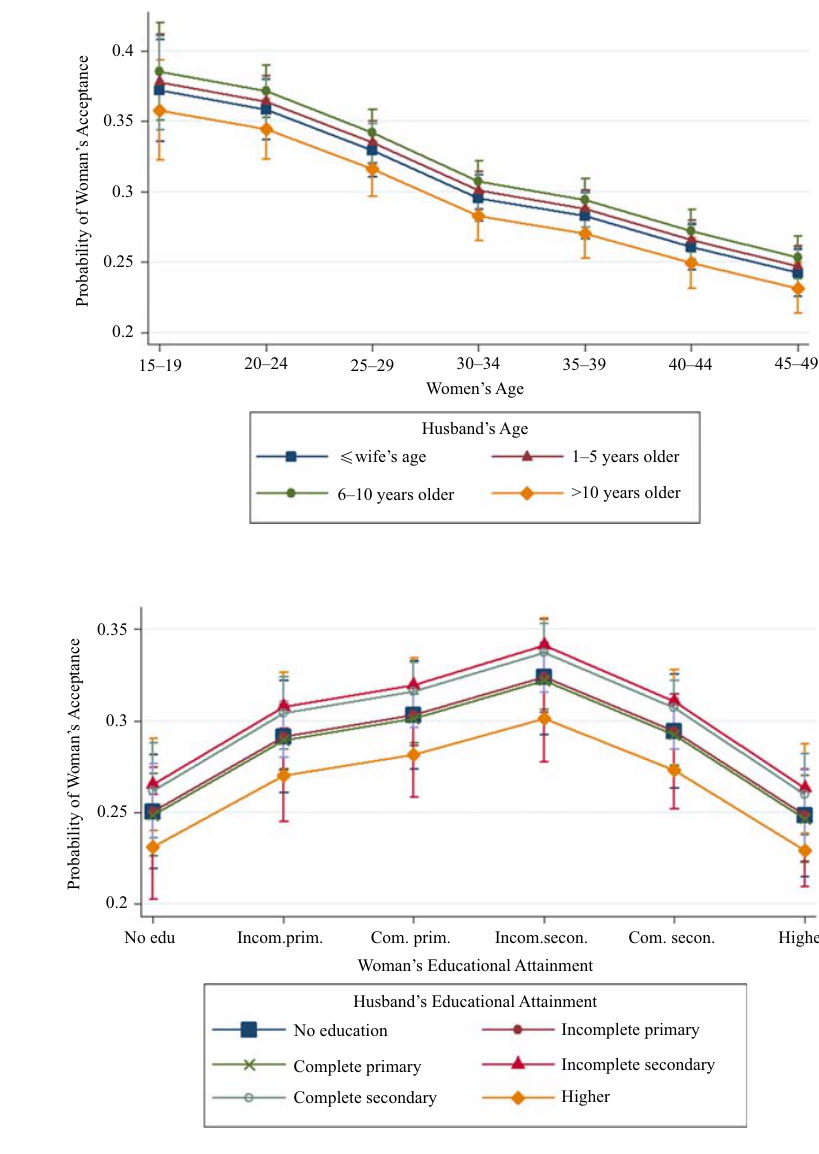
Figure 3. Probability of women ’ s acceptance based on the educational attainment of